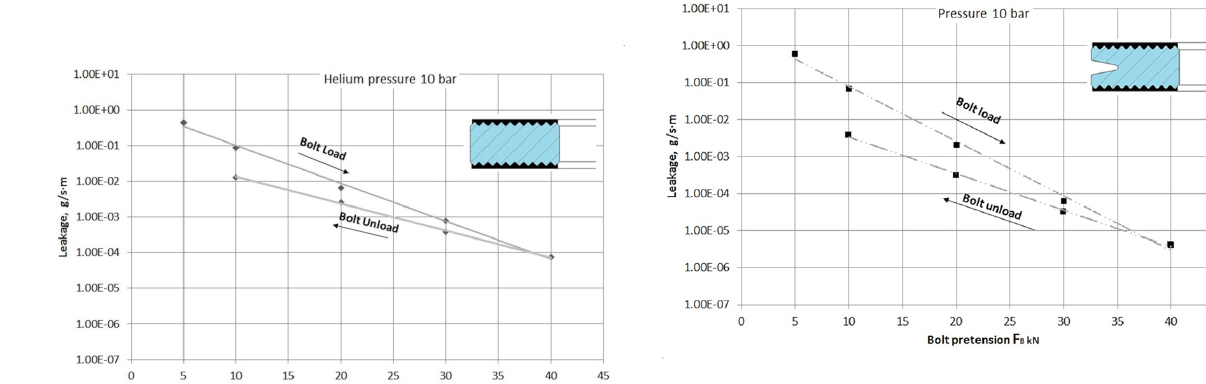
Figure 8: Leakage characteristic in load and unload state of the bolt in case of the joint gasketed with gasket’s core grooved on external